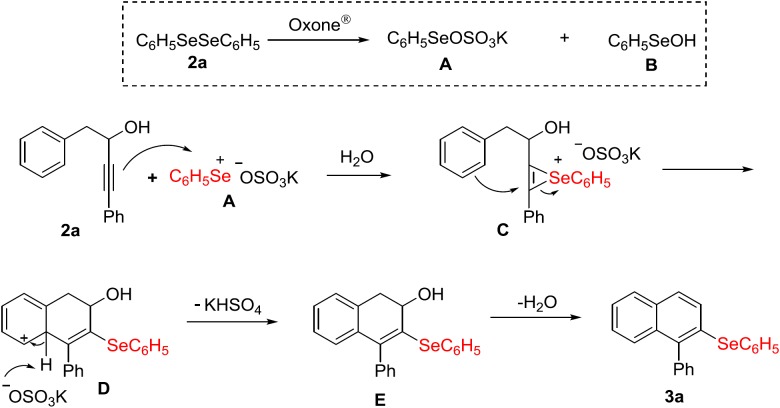
Proposed mechanism.